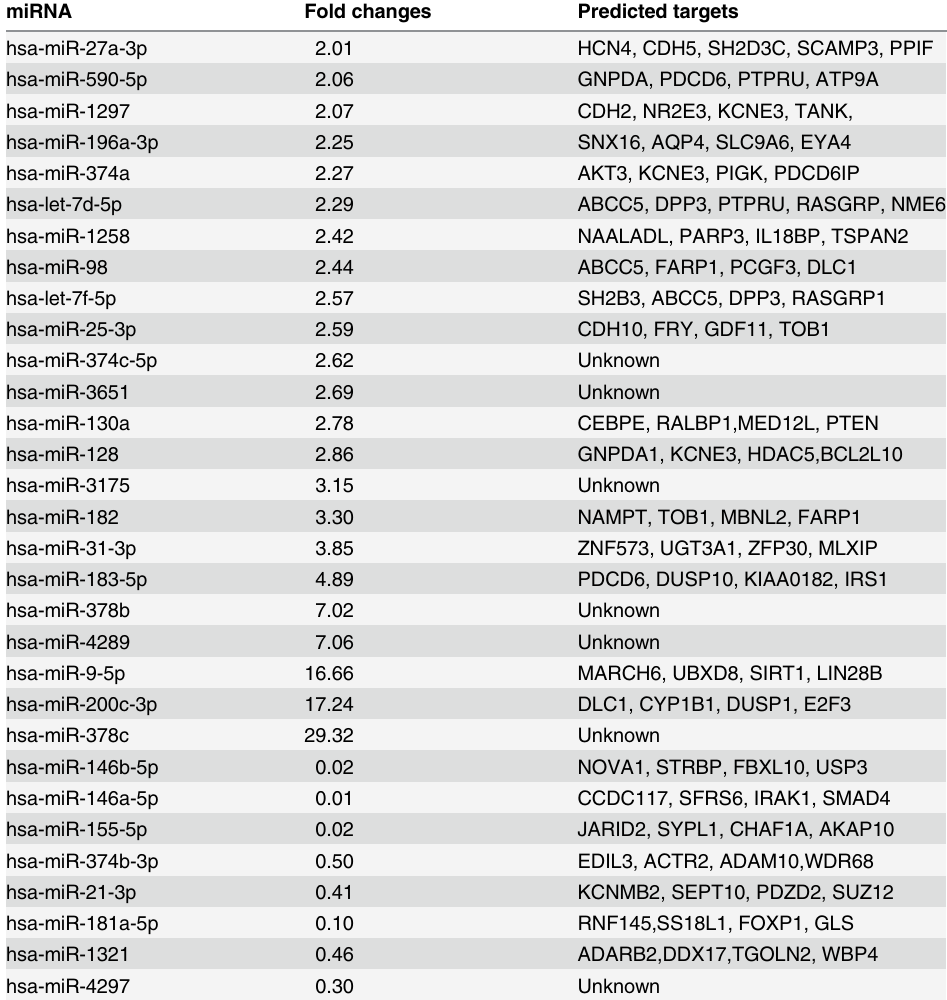
Table 1. 32 differentially expressed miRNAs in A2780/DDP. miRNA Fold changes Predicted